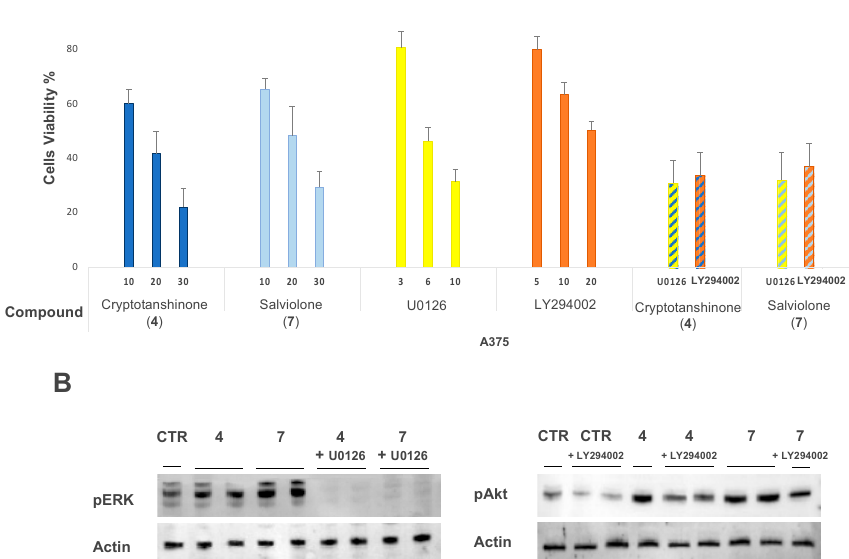
Figure 5. Cell viability of salviolone or cryptotanshinone treatment in the presence or absence of ERK1/2 or Akt inhibitors. ( A ) SRB assay compares the effects on A375 cell viability of 72-h treatment with salviolone ( 7 ) (light blue) or cryptotanshinone ( 4 ) (blue) alone, U0126 (yellow) or LY294002 (orange) alone, and compound 7 or 4 (20 µM) plus ERK1/2- or Akt-inhibitor (10 µM) co-administration (striped yellow and striped orange, respectively). ( B left) Immunoblot attests the inhibitory effect of U0126 (10 µM) on ERK1/2 activation in a co-treatment with 20 µM cryptotanshinone ( 4 ) or salviolone ( 7 ). (B, right) Immunoblot attests the inhibitory effect of LY294002 (10 µM) on Akt activation in a co-treatment with 20 µ M cryptotanshinone ( 4 ) or salviolone ( 7 ). Data acquired calculating the average ± SD of values obtained from three to four independent experiments were compared to data from non-treated